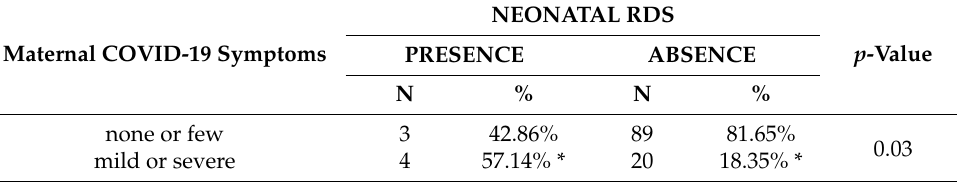
Table 5. The correlations between the presence of neonatal respiratory distress syndrome (RDS) and the severity of maternal COVID-19 symptoms. LEGEND: OVB (operative vaginal birth), SVB (spontaneous vaginal birth), CS (cesarean section); *: subgroups significantly different p < 0.001; n.s.: not statistically significant, p > 0.05. The percentages considered the missing data, which were not reported for reasons of